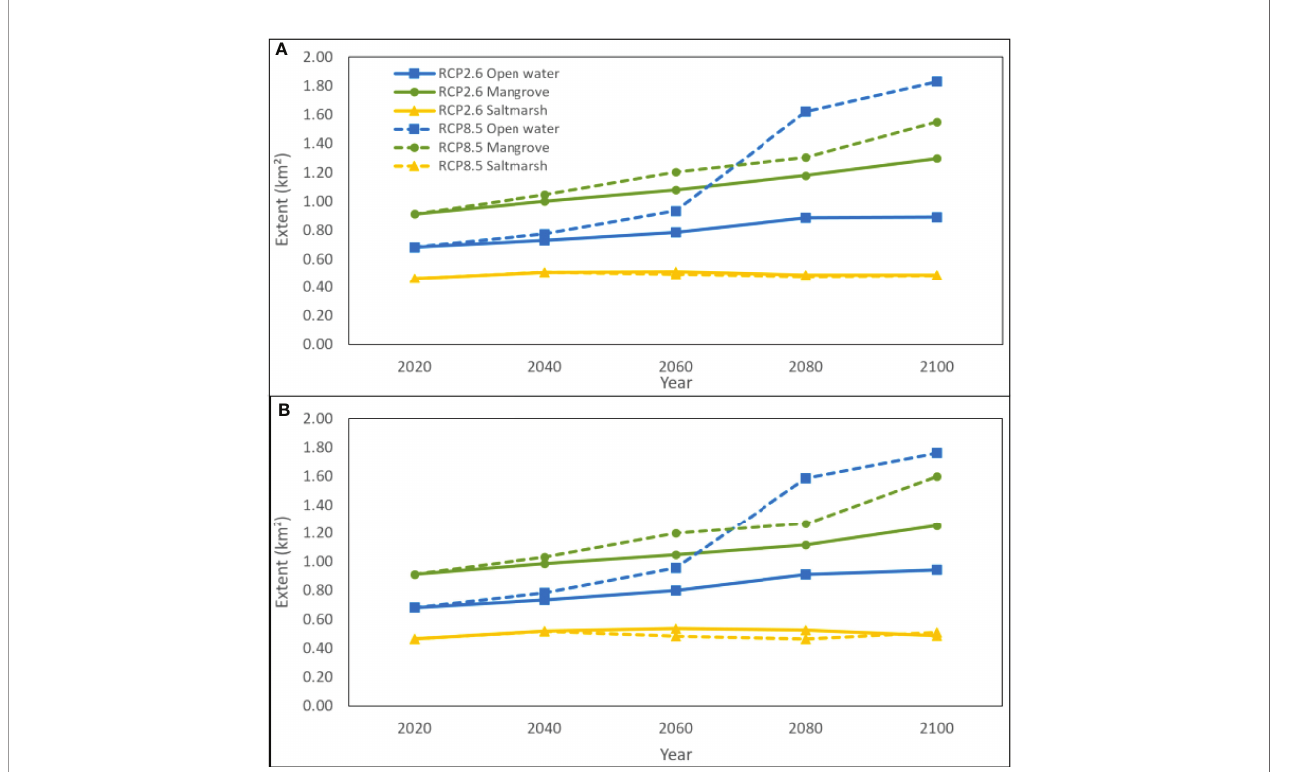
FIGURE 11 | Projections of river (blue squares), mangrove (green circles) and saltmarsh (orange triangles) extents in response to the lower RCP2.6 SLR scenario (solid) and the higher RCP8.5 SLR scenario (dashed) for WEM scenarios Linear 1 (panel A ) and Linear 2 (panel B